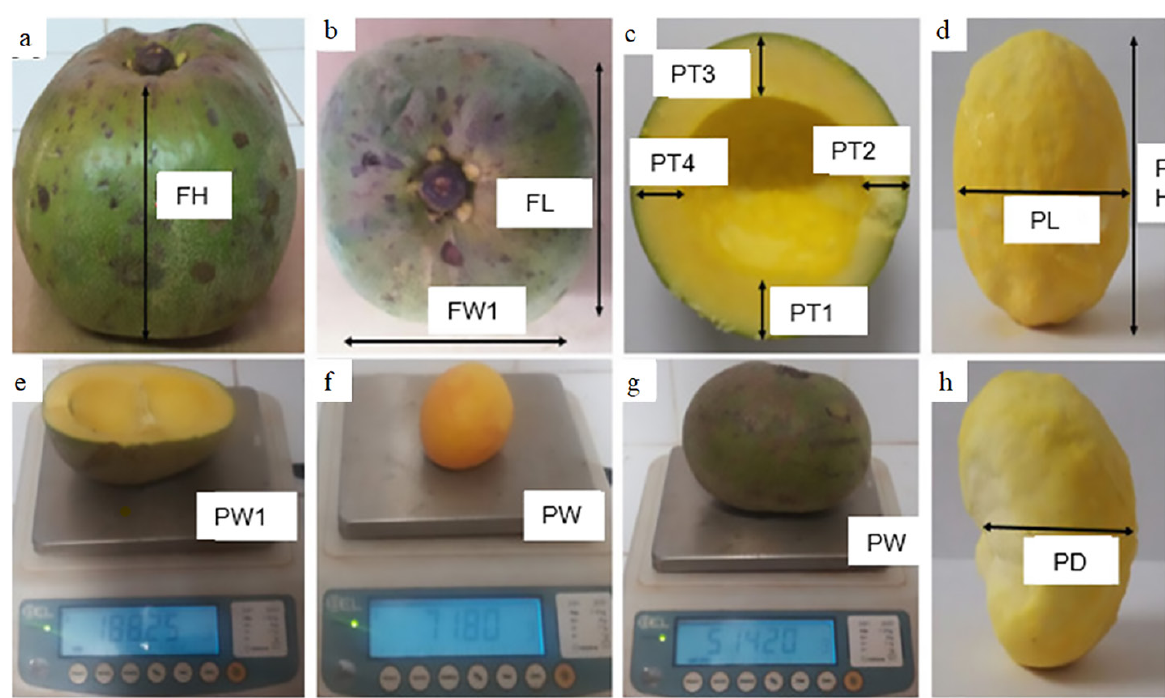
Figure 2. Measurements in fruits of pequi ( Caryocar brasiliense ) with and without thorns at endocarp. (a) FH: Fruit Height (mm), (b) FL: Fruit Length (mm), FW1: Fruit Width (mm), (c) PT1, PT2, PT3 and PT4: Peel Thickness, (d) PL: Pyrene Length (mm), PH: Pyrene Height (mm), (e) PW1: Peel Weight (g), (f) PW: Pyrenes Weight (g), (g) PW: Pyrenes Weight (g), (h) PD: Pyrene Diameter